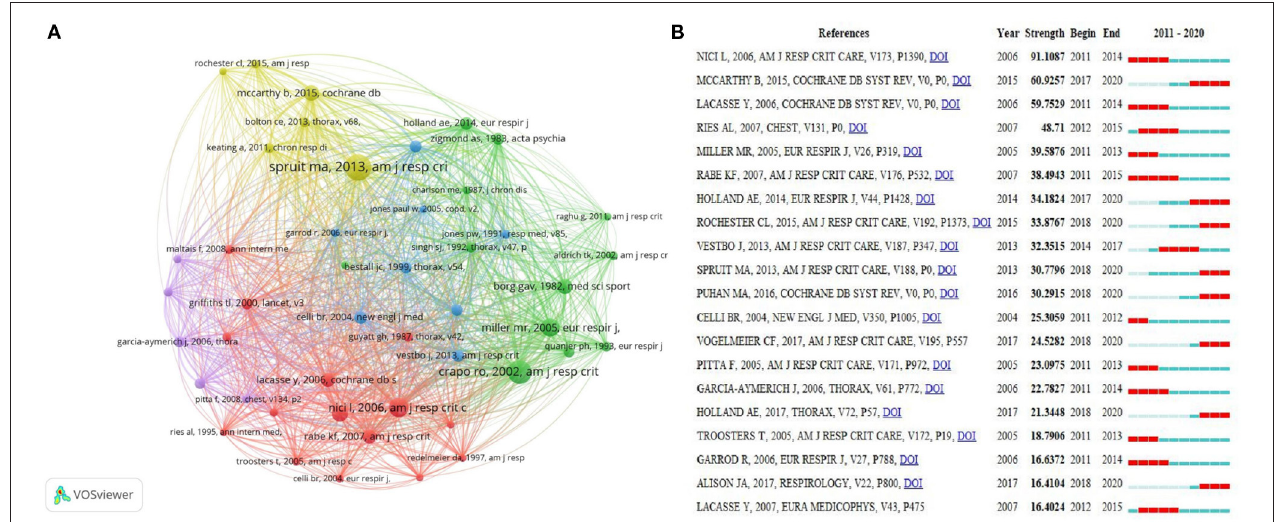
FIGURE 7 | (A) The network map of co-cited references for research on pulmonary rehabilitation (T ≥ 100). (B) Top 20 References with the Strongest Citation Bursts on pulmonary rehabilitation.